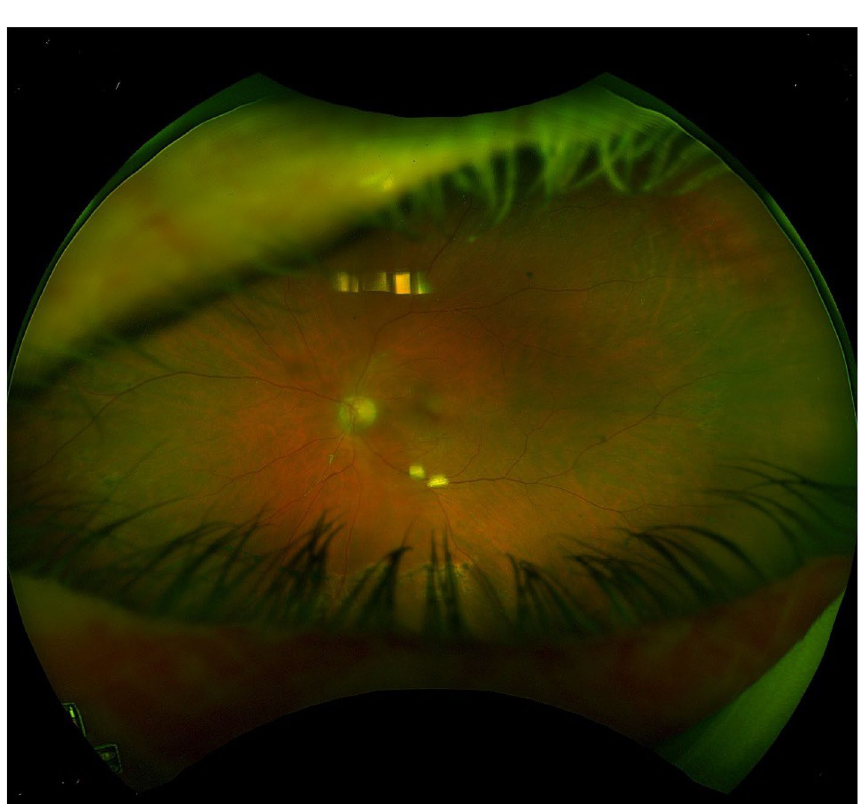
Fig. 4 Optos photo of left eye 2 months after initial